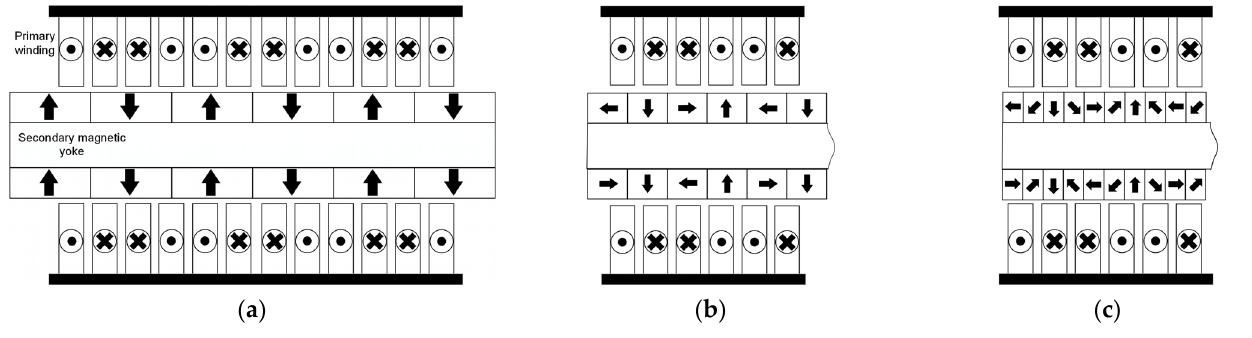
Figure 4. Cross-section diagram of three secondary structures: ( a ) Structure of electromagnetic actuator with radially magnetized secondary; ( b ) Structure of electromagnetic actuator with Halbach three-section magnetized secondary; ( c ) Structure of electromagnetic actuator with Halbach five- section magnetized secondary. Table 1. The parameters of the electromagnetic actuator.